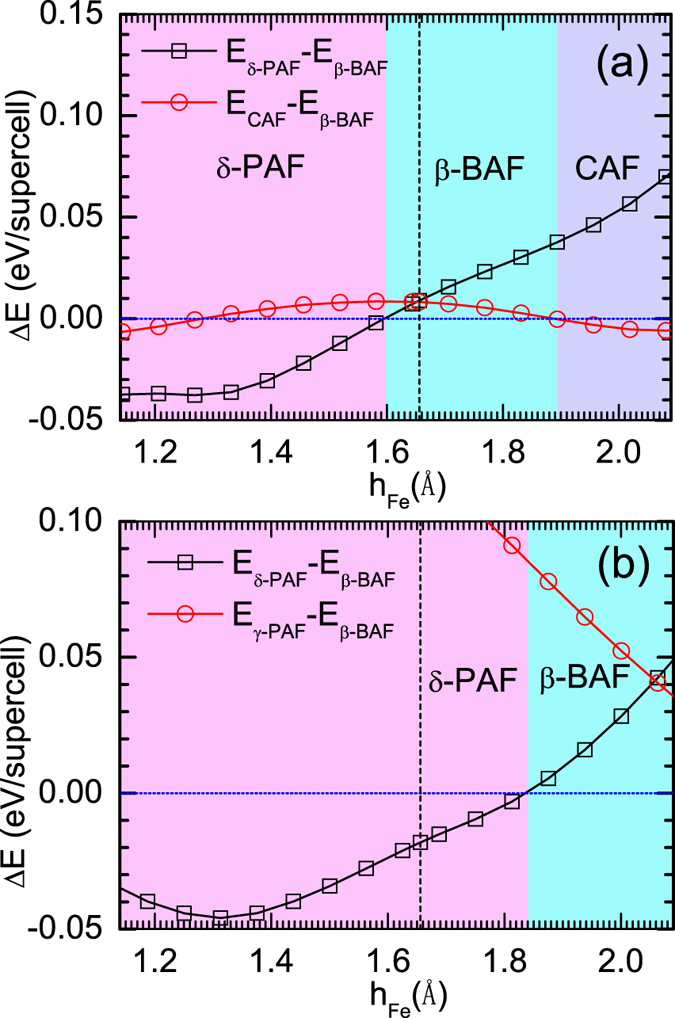
Differences of the total energies among three competing phases in the case of Fe17Te16 (a) and Fe9Te8 (b) which corresponds to a stoichiometry of Fe1.0625Te and Fe1.125Te, respectively.The dashed line indicates the experimental value of the position of interstitial Fe15. Different phases are marked by different colors.